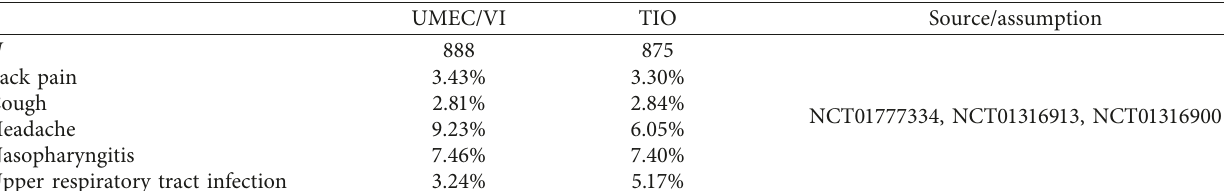
Table 3: Adverse event rates of UMEC/VI and TIO.